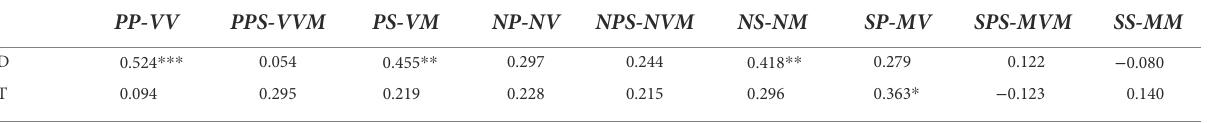
TABLE 4 Spearman’s rho correlation coefficients between the probabilities of a “yes” answer in the verbal and pictorial conditions separately for the dyslexic (D) and typically developing (T) groups.